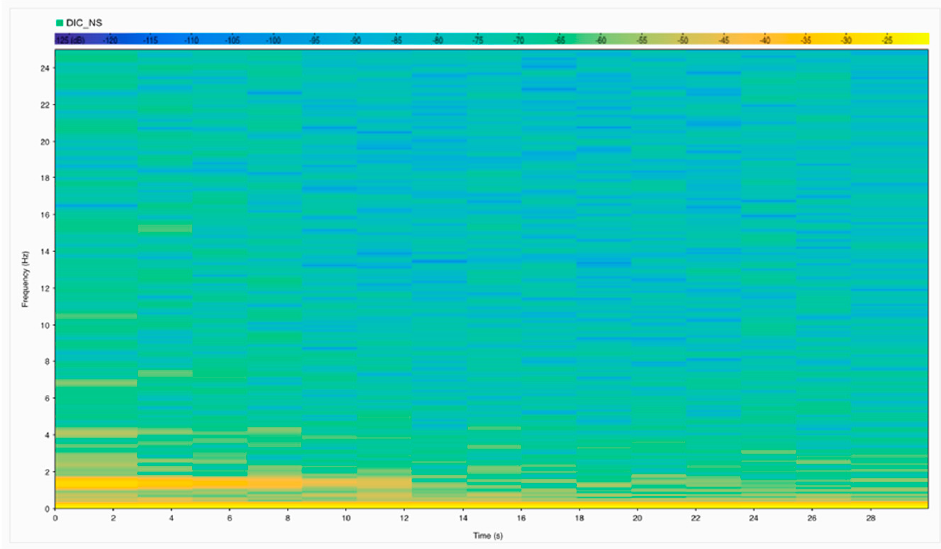
Figure 18. Spectrogram of the DIC north-south signal. (Figure 19) and in the south-east direction (Figure 20).